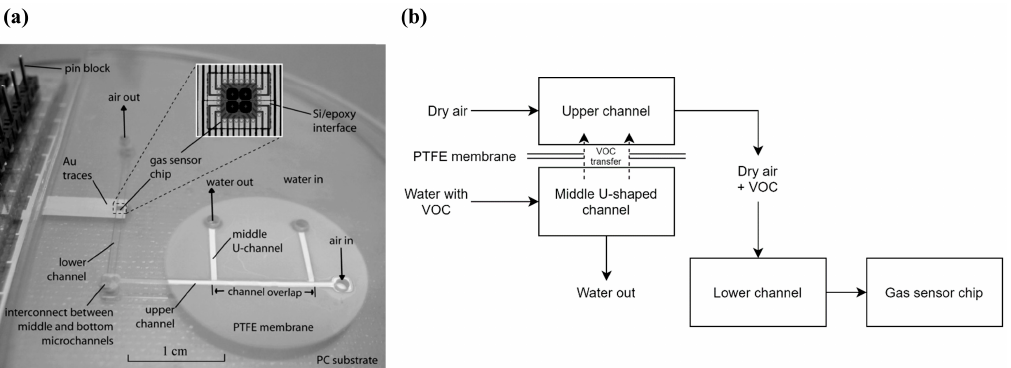
Figure 3. Photograph and schematic of the system. ( a ) Photograph of the fabricated device. Reproduced with permission from [19] Copyright 2007, Elsevier. ( b ) Simplified schematic of the system.